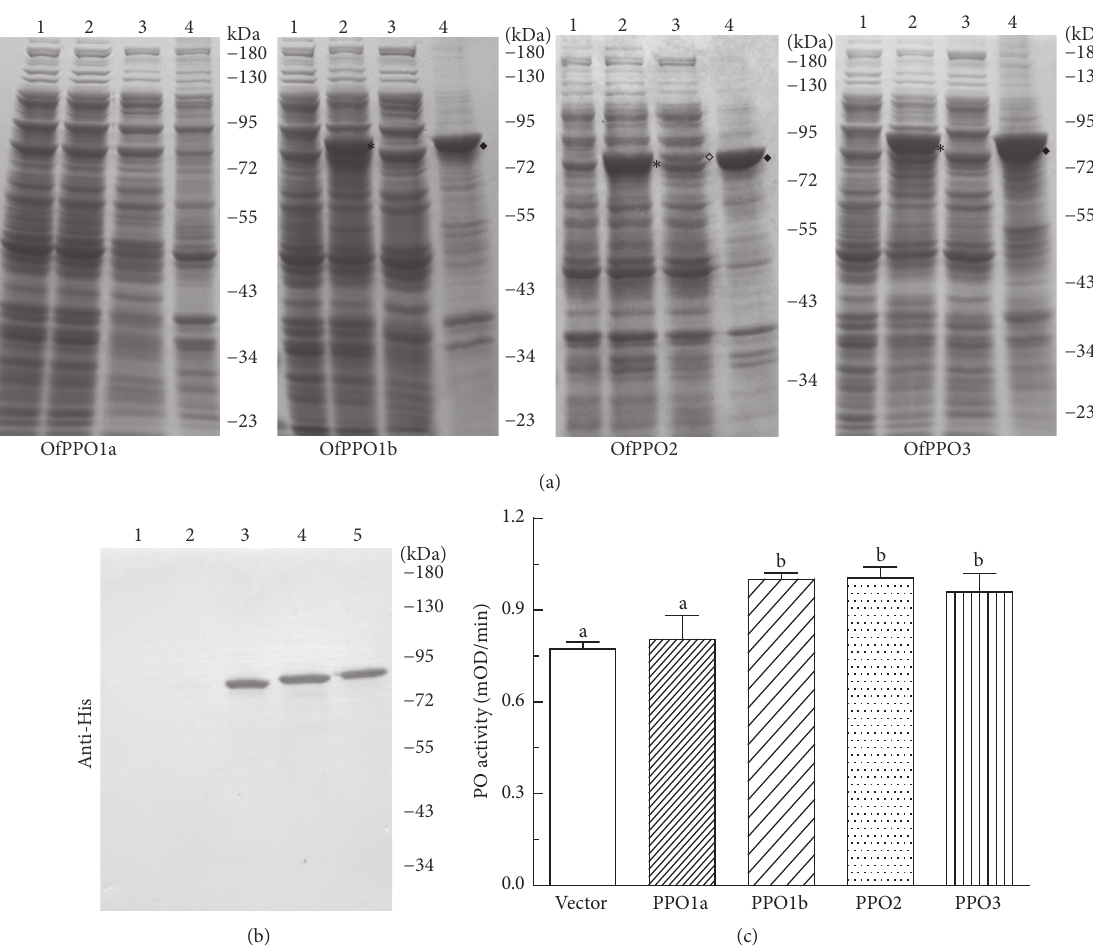
Figure 6: Recombinant expression of four O. furnacalis PPOs in E. coli . (a) SDS-PAGE analysis of recombinant PPOs. Four O. furnacalis PPOs were expressed in E. coli at 18 ∘ C for 12 h. The cultured cells were harvested and treated as described in Materials and Methods. The obtained protein samples were then subjected to 10% SDS-PAGE and visualized by Coomassie brilliant blue staining. Lane 1: 10 𝜇 L of cell lysate collected before the addition of IPTG. Lane 2: 5 𝜇 L of cell lysate collected 12h after the addition of IPTG. Lane 3: 10 𝜇 L of supernatant of cell lysate treated by sonication (soluble faction). Lane 4: 10 𝜇 L of precipitate of cell lysate treated by sonication (insoluble fraction). The total recombinant OfPPO1b, OfPPO2, or OfPPO3 is indicated by the asterisk, while the insoluble protein is indicated by solid diamond. The soluble OfPPO2 is indicated by hollow diamond. (b) Western blot analysis of recombinant PPOs. The obtained samples in (a) were subjected to immunoblotting using mouse anti-His as primary antibodies. Lane 1: 1 𝜇 L of cell lysate collected before the addition of IPTG. Lanes 2– 5: 1 𝜇 L of cell lysate collected 12 h after the addition of IPTG, which contained recombinant OfPPO1a, OfPPO1b, OfPPO2, and OfPPO3, respectively. (c) PO activity assay of recombinant PPOs. The cell lysate was prepared as described in “Materials and Methods and incubated with 30% ethanol for activation [30]. PO activity of each protein sample was measured with dopamine as substrate. The bars represent mean ± SD ( 𝑛 = 3 ). Bars labeled with different letters (a or b) are significantly different (one-way ANOVA, followed by the Newman-Keuls test, 𝑝 < 0.05 ).